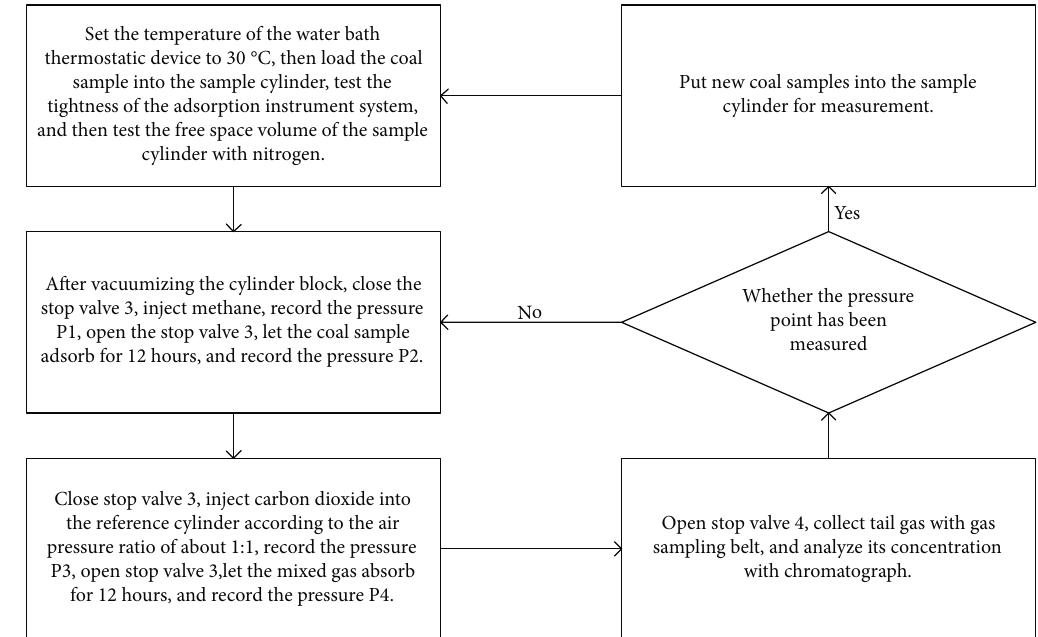
Figure 2: Experimental